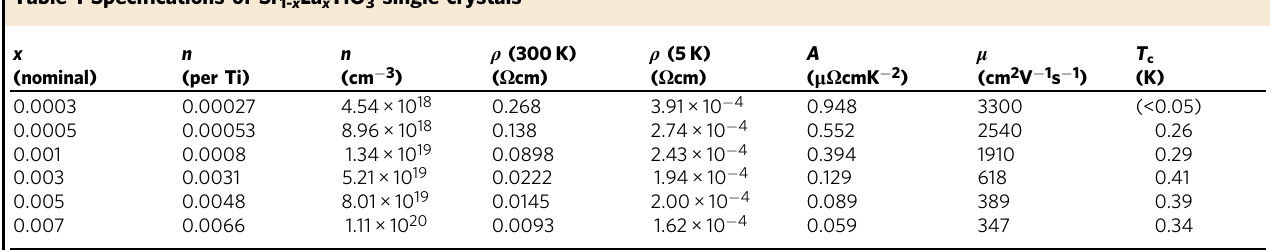
Fig. 1 Resistivity and superconductivity of Sr 1- x La x TiO 3 single crystals. a Temperature dependence of resistivity in Sr 1 − x La x TiO 3 single crystals with nominal values of x ~ 0.0003, 0.0005, 0.001, 0.003, 0.005, and 0.007 with which we substituted La for Sr in the raw material. The inset shows that the number of electrons per Ti site determined using the Hall effect measurements was almost identical to the nominal value of x . b , c Resistivity in a re-plotted vs. T 2 . The straight dotted lines represent the best fi ts to the data below 40 K. As x increases, the slope gradually decreases, and the deviation point of the straight line from the real data shifts to higher temperatures. d Resistivity measured using a 3 He/ 4 He dilution refrigerator plotted against T below 1 K for the same samples shown in a . With increasing La substitution, the residual resistivity decreases monotonously, whereas the value of T c increases up to x ~ 0.003 and decreases for x ~ 0.007 Table 1 Speci fi cations of Sr 1- x La x TiO 3 single